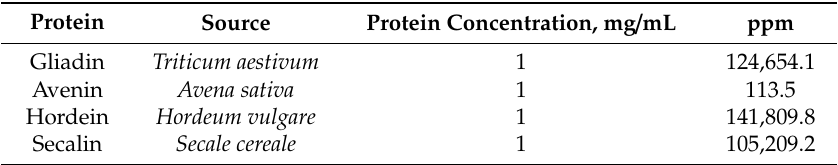
Table 5. Determination of gliadin content in various cereals ethanolic extracts (ppm) using X6 antibody-based